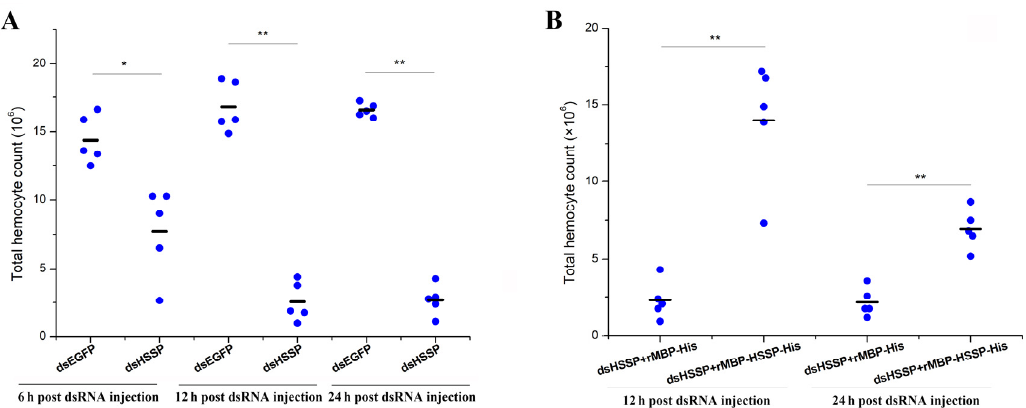
Figure 9. The effect of LvHSSP on the total hemocyte counts. ( A ) The total hemocyte counts after knockdown of LvHSSP . dsEGFP, injected with EGFP dsRNA; dsHSSP, injected with LvHSSP dsRNA. ( B ) The total hemocyte counts after knockdown of LvHSSP and rescue with recombinant LvHSSP protein. dsHSSP + rMBP-His, injected with LvHSSP dsRNA and rMBP-His tag protein; dsHSSP + rMBP-HSSP-His, injected with LvHSSP dsRNA and recombinant rMBP-HSSP-His protein. Bar, median of THC. Stars (*) indicate significant difference ( p < 0.05) and (**) indicate extremely significant difference ( p < 0.01) in the THC between the two treatments.